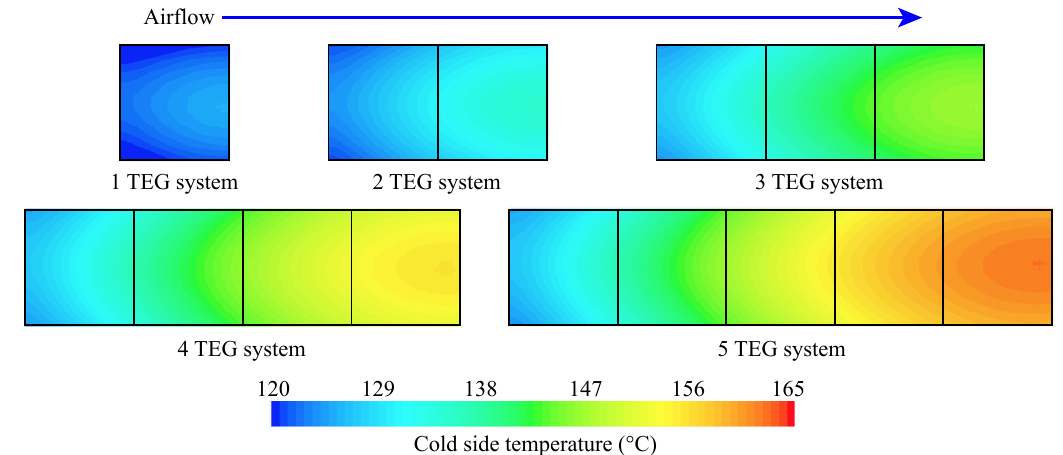
Figure 12. TEG cold side temperature distribution of all the SMF systems at their most effective fan speeds. The hot side temperature of all the systems is between 193 and 198 ◦ C.